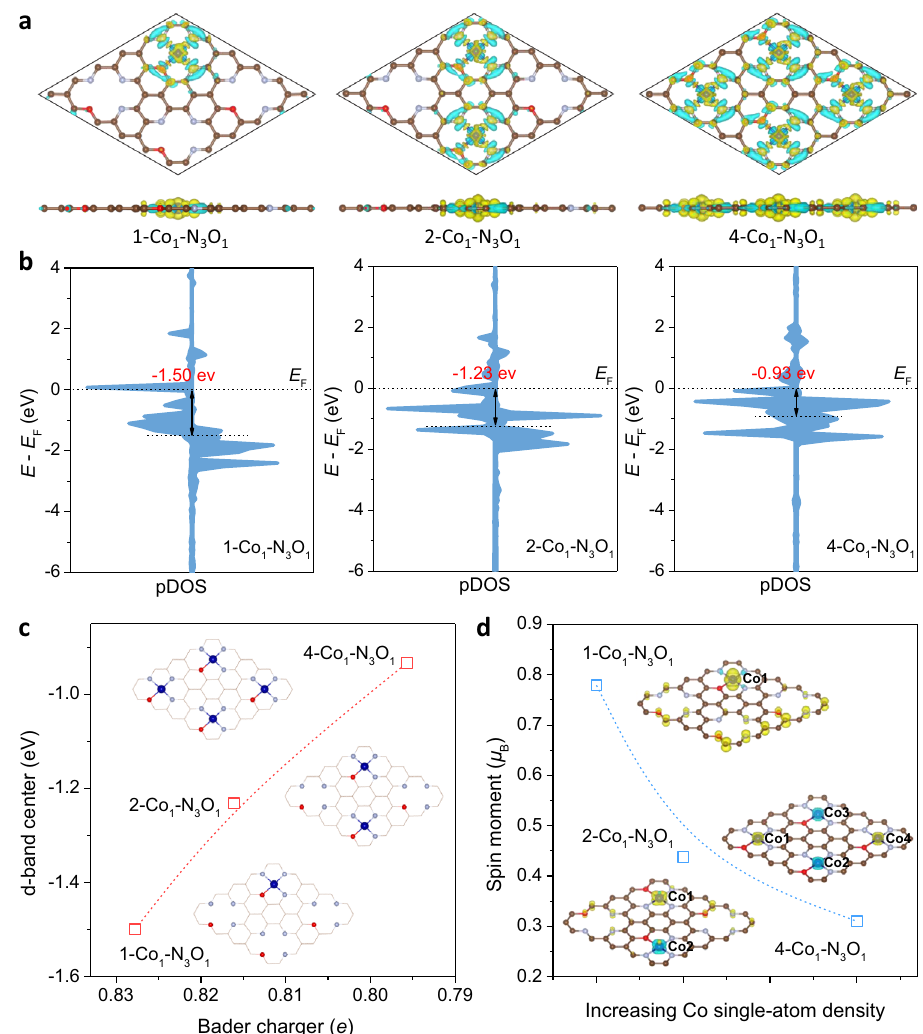
Fig. 3 | Theoretical analysis of electronic structure of Co1/NOC with different densities.a Topandsideviewsofdifferentialchargedensityofx-Co 1 -N 3 O 1 models. Isosurface:0.005e/Å – 3 .Colorlegend forisosurface:blue,chargedepletion;yellow, charge accumulation. b Projected density of state (pDOS) for the Co 3d orbital.